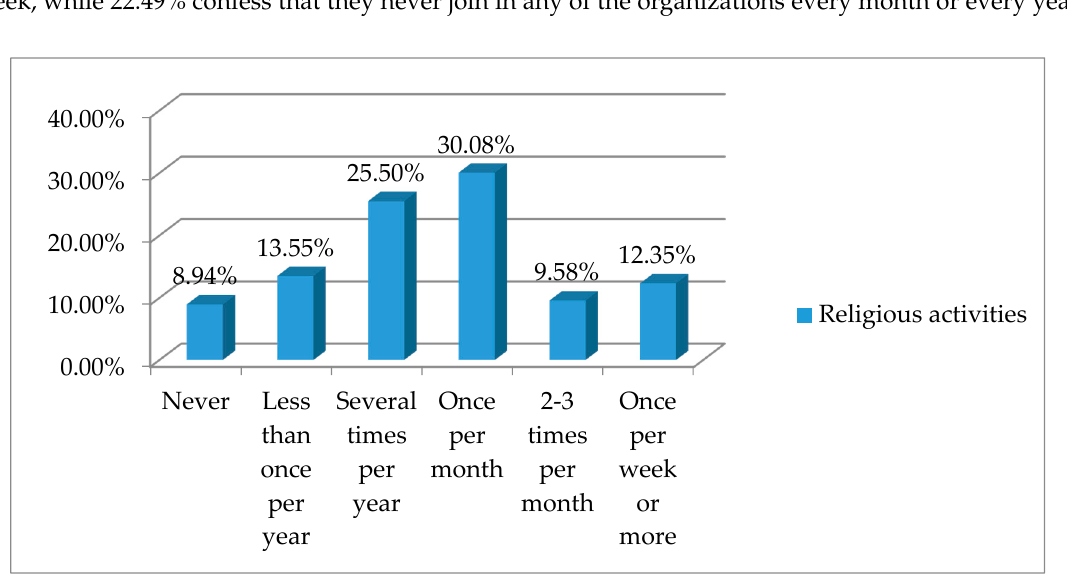
Figure 3. The frequency city dwellers participate in Christian activities.